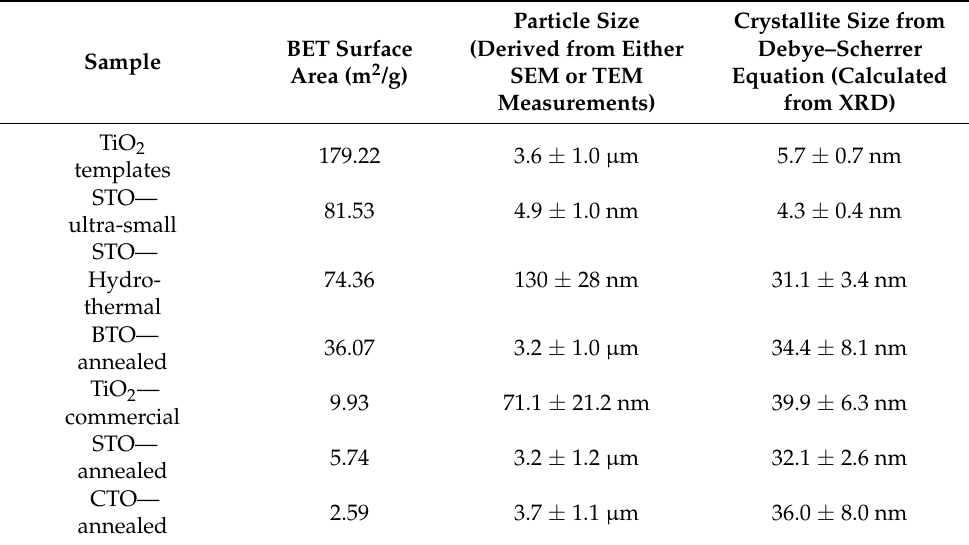
Table 1. BET surface area measurements, microscopy-derived particle sizes, and calculated Debye– Scherrer crystallite sizes of ATO samples, TiO 2 templates, and commercial TiO 2 .